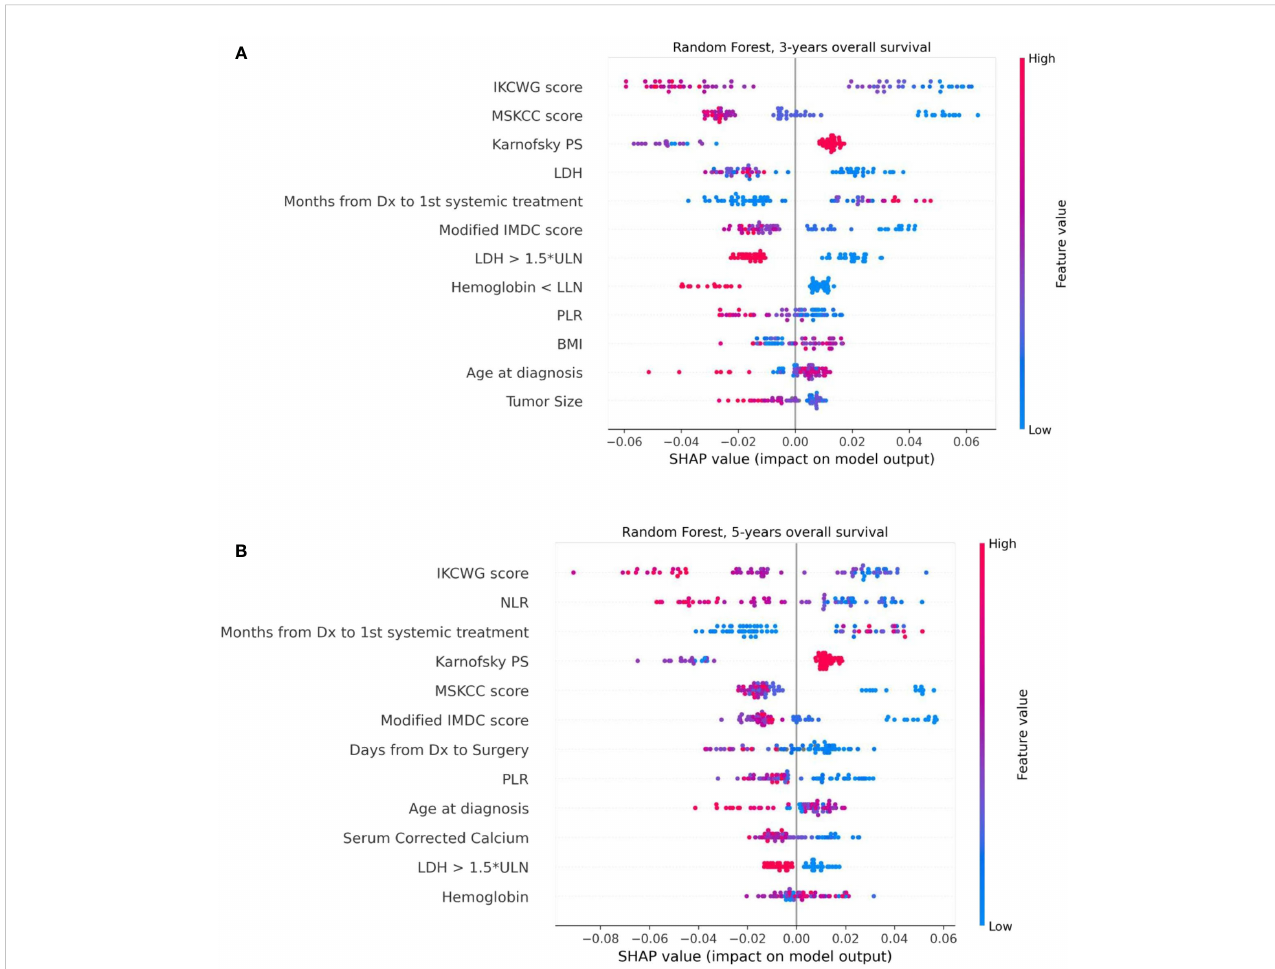
FIGURE 6 The Shapley additive explanations summary plots of 12 top features of the Random Forest model, ordered by their impact on 3-year (A) and 5-year (B) survival,